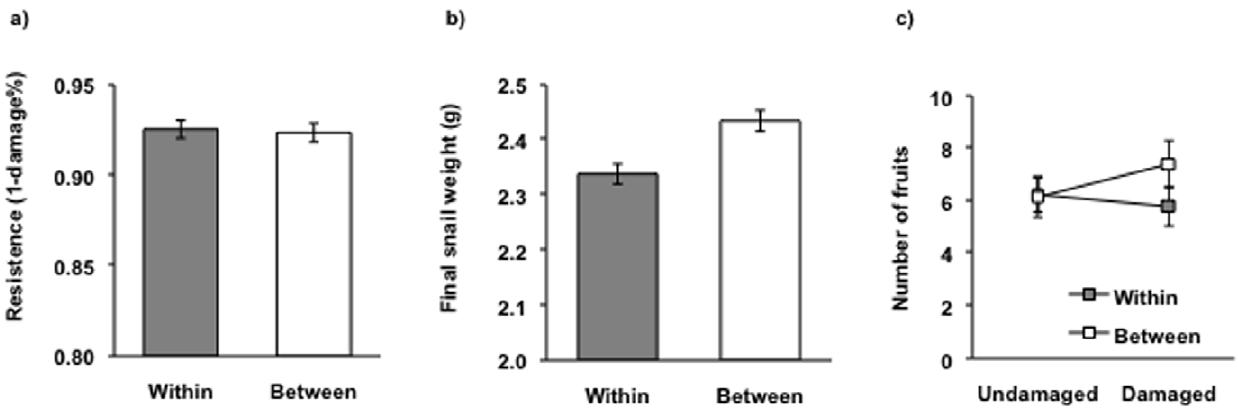
Figure 1. Mean effects of outbreeding on resistance and tolerance. Average resistance, measured as a) 1- proportion of damaged leaf area, b) final snail mass in the snail herbivory experiment with plants resulting from two generations of within- and between-population crosses of plants from 13 populations of Lychnis flos-cuculi . c) Effects of outbreeding on tolerance to clipping in the clipping experiment with plants resulting from two generations of within- and between-population crosses of plants from 19 populations of Lychnis flos-cuculi . Average effects of clipping on number of fruits produced after damage (1c). Covariate-adjusted least-squares means estimates and estimated standard errors are presented.